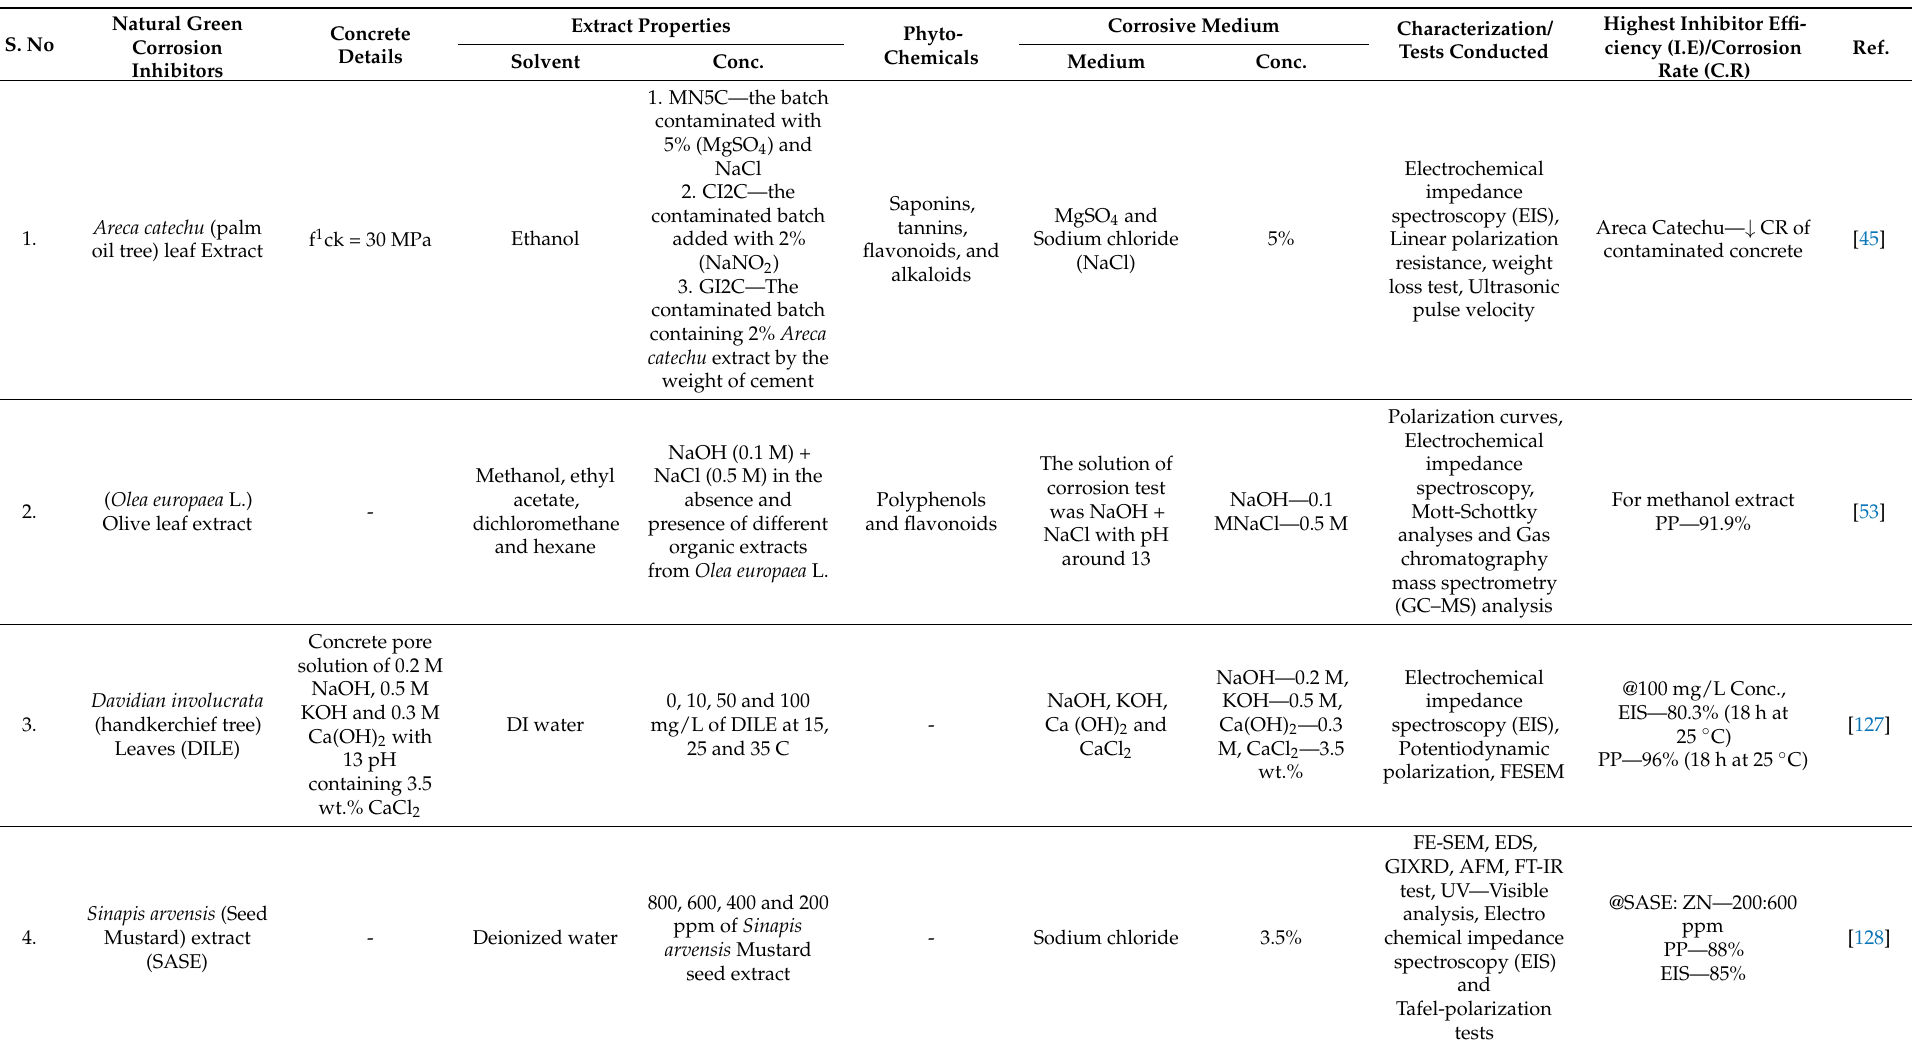
Table 4. Mild Steel